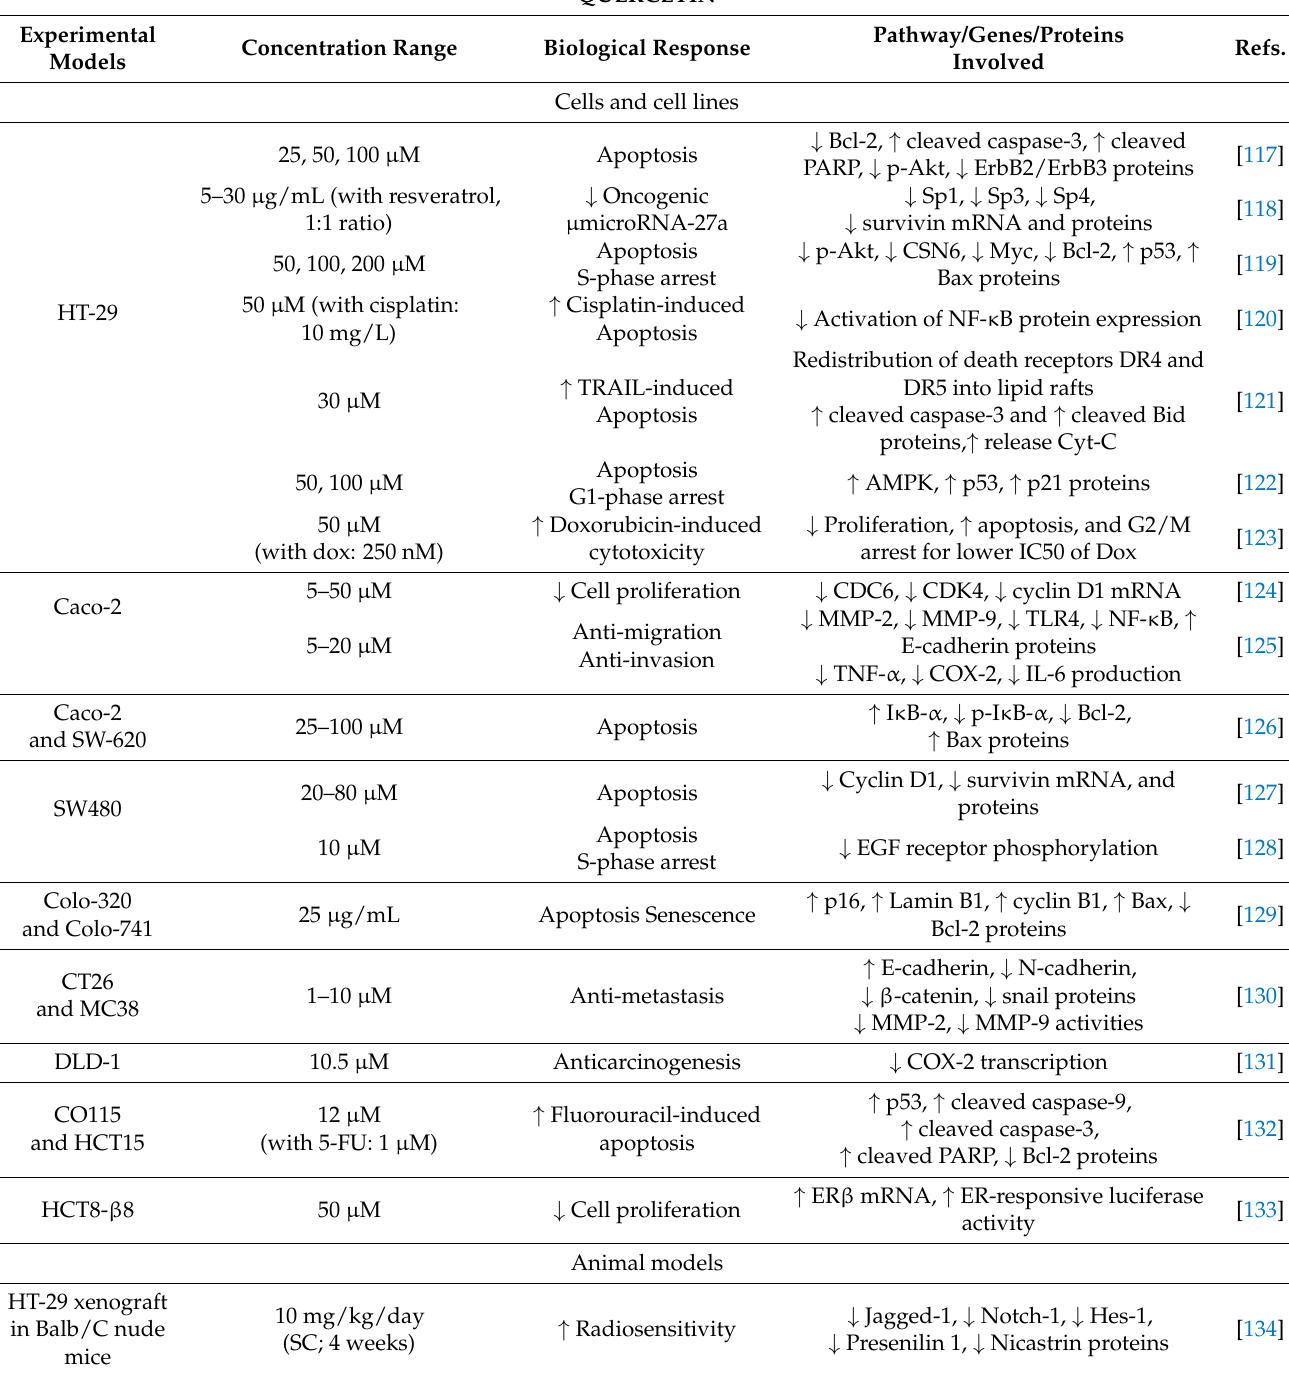
Table 7. Antitumoral effects of quercetin in colorectal